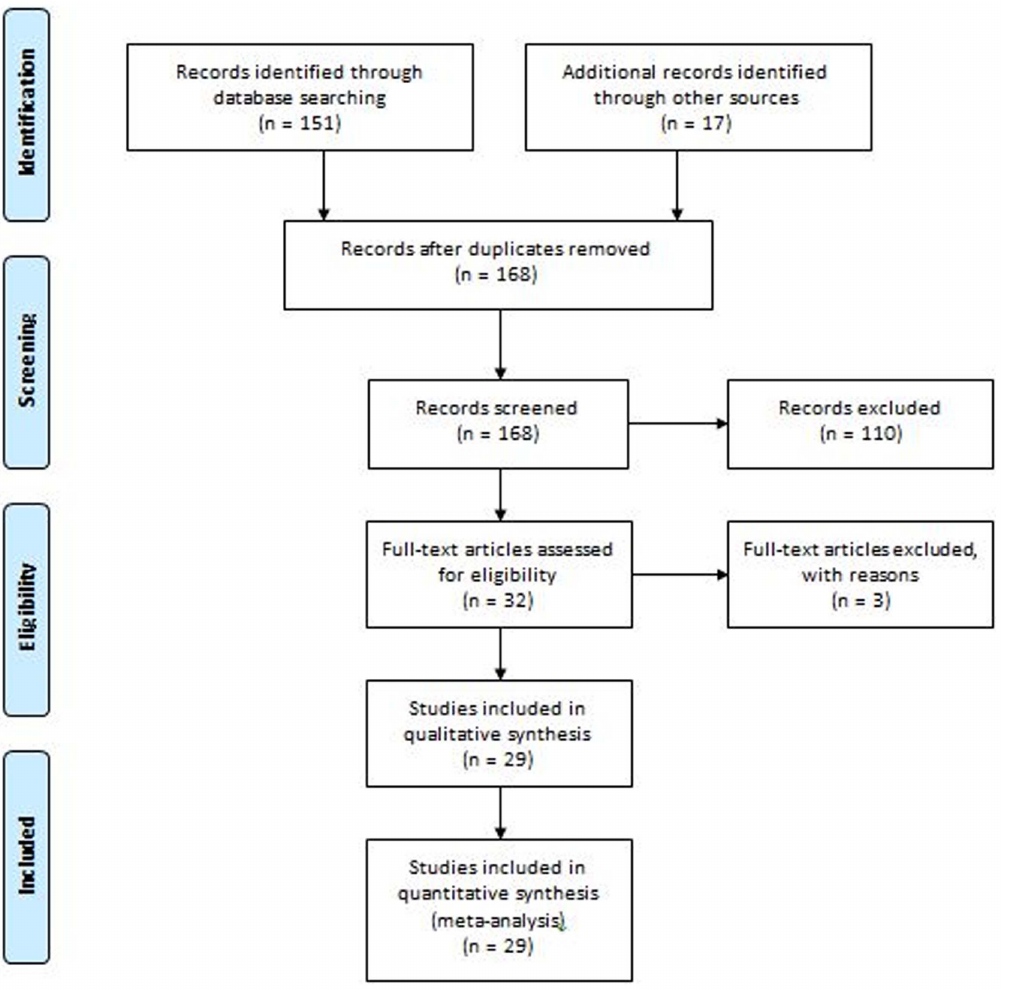
Figure 1. Flowchart of study screening and selection process.